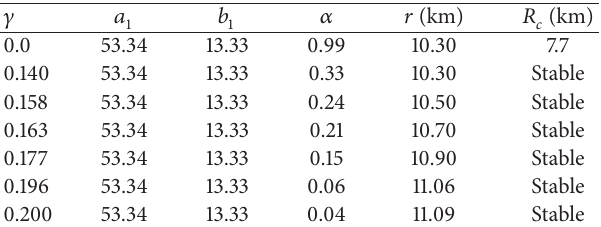
Table 2: Stability of PSR J1614-2230 when 𝑠 1 = 0 and 𝛼 , 𝛾 are variable.